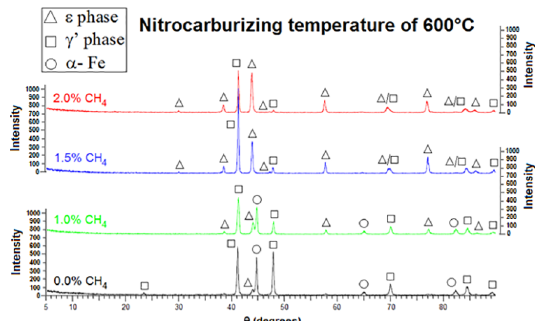
Figure 2. XRD diffractograms for samples treated at 600°C.